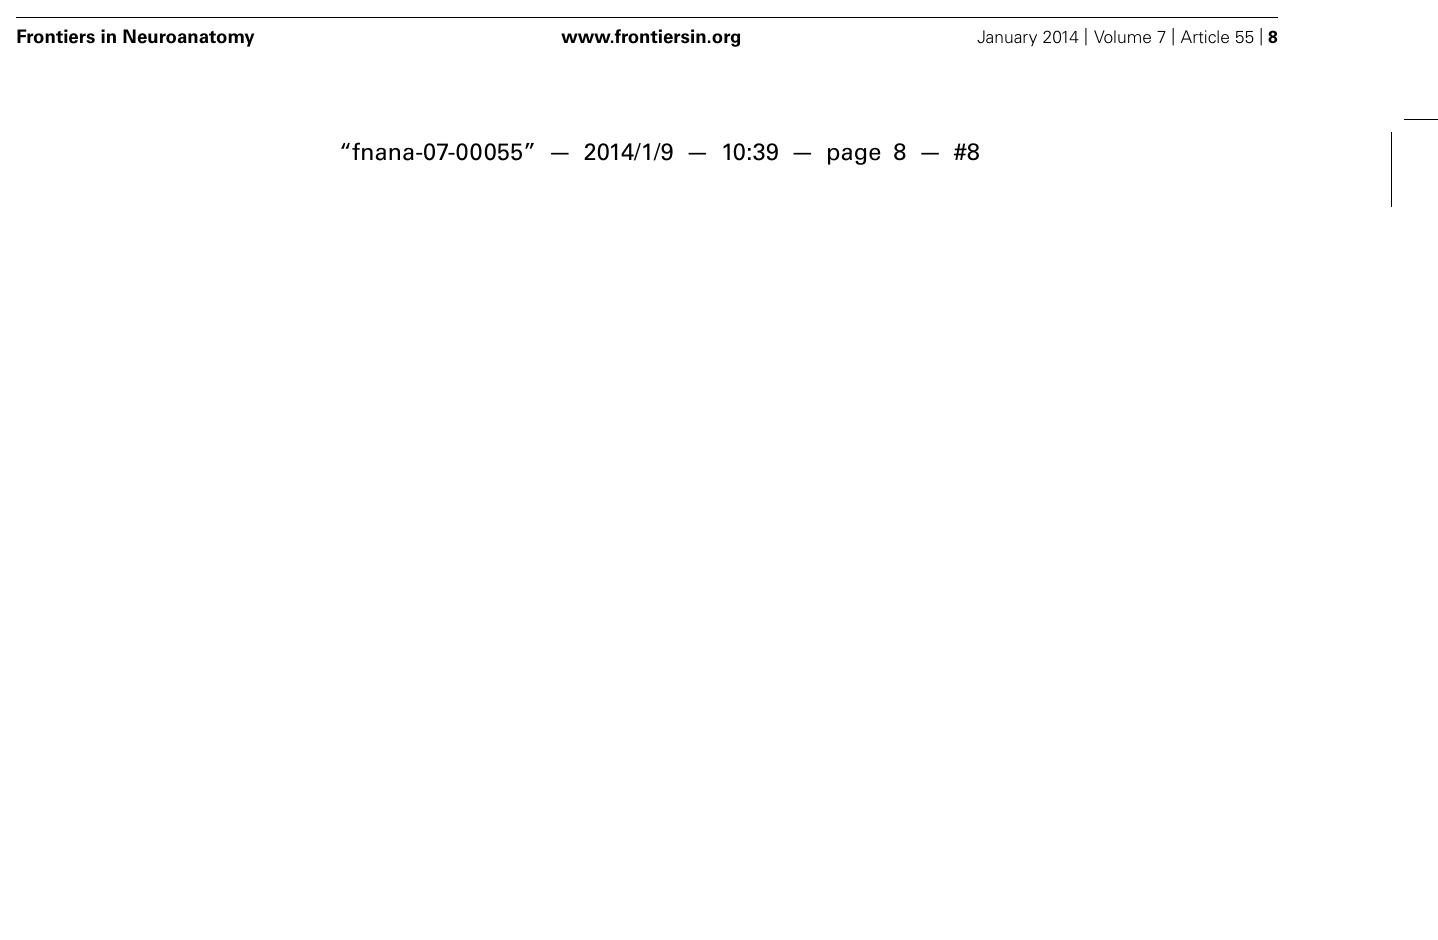
ascending and descending paths likely transmit different